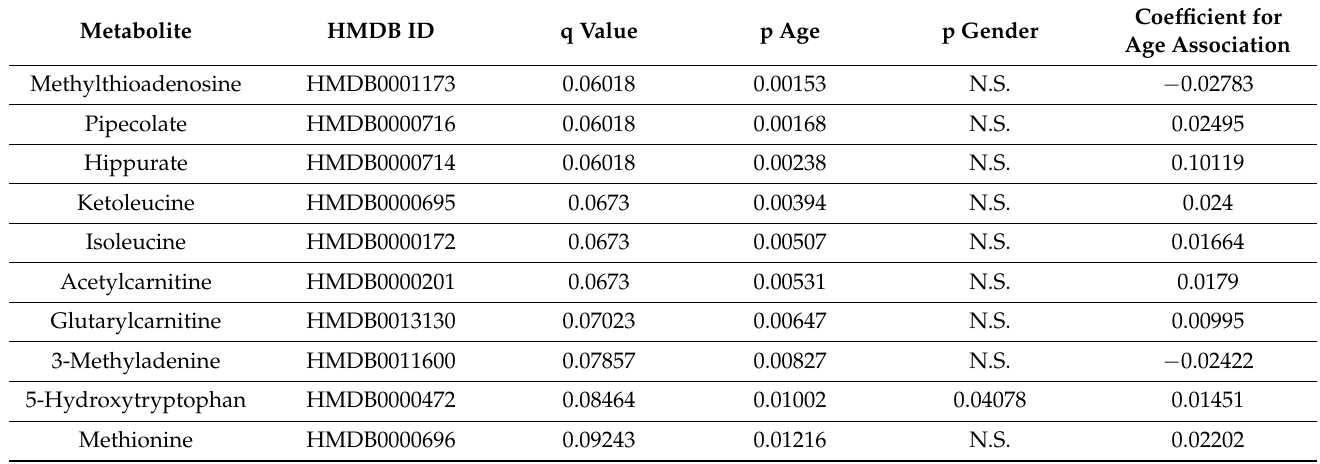
Figure 1. Intersections of biofluids in which the 31 metabolites previously not reported as CSF metabolites in the HMDB have been detected (based on HMDB data). Table 2. Age association in CSF from healthy